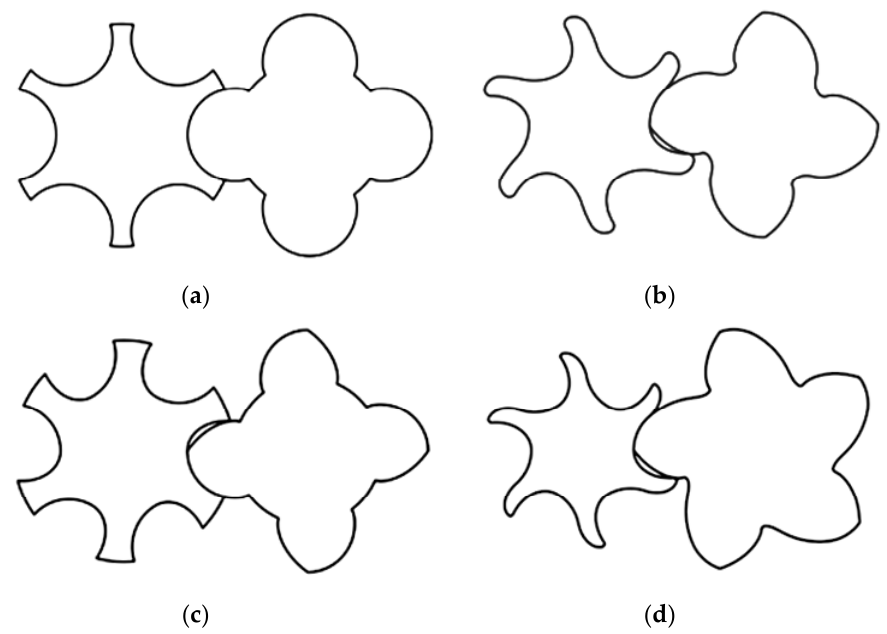
Figure 6. The typical profiles of each stage of the development of the profile: ( a ) symmetrical circular arc profile; ( b ) unilateral asymmetrical cycloid; ( c ) GHH profile; ( d ) Hokuetsu profile.